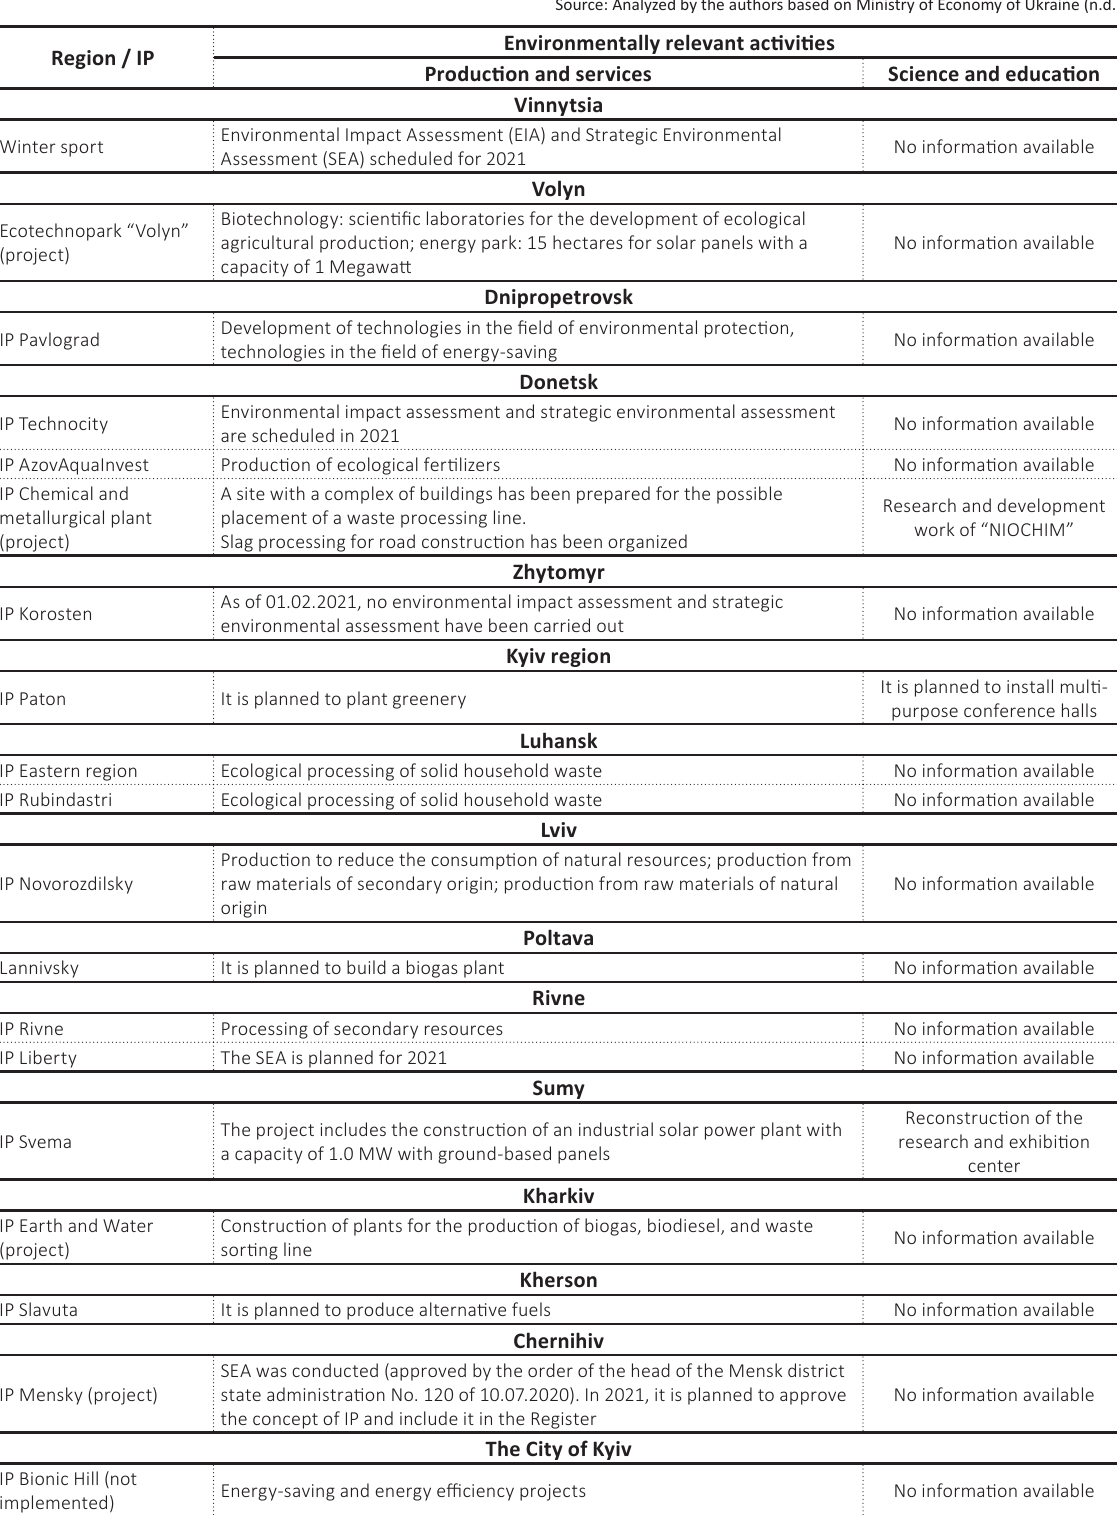
Table A1. Ecologically relevant and scientific-educational activities of industrial parks by regions of Ukraine,